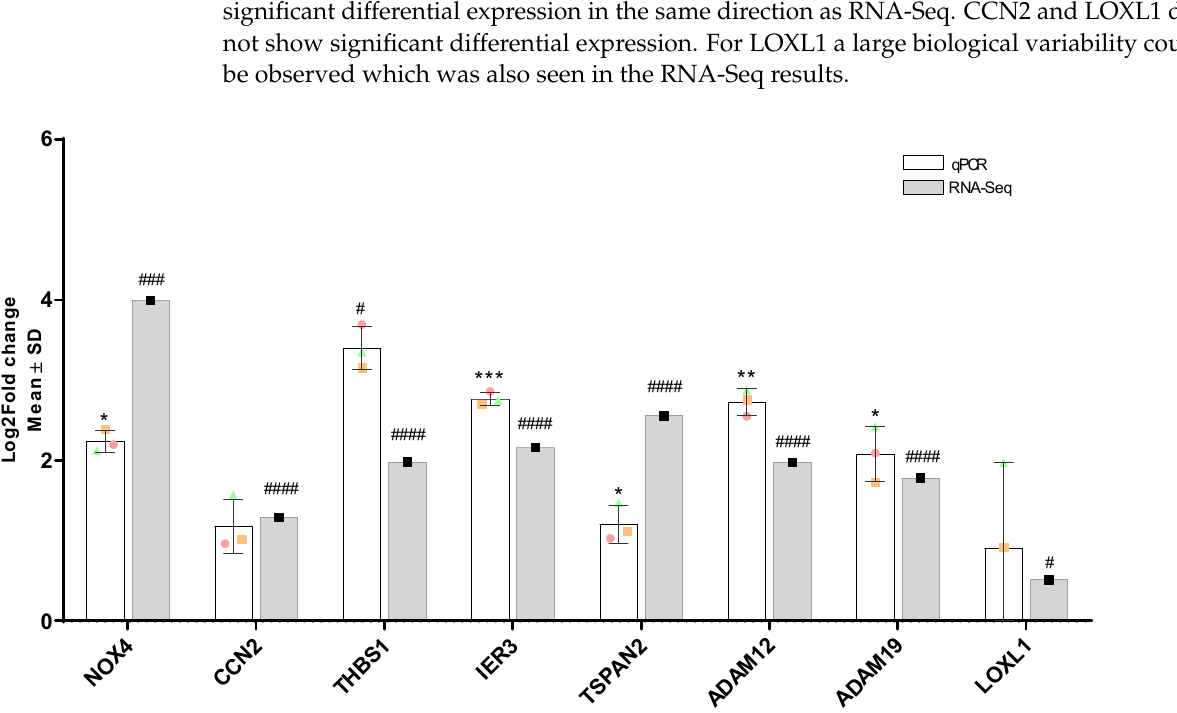
Figure 9. RT-qPCR confirmation and comparison of RNA-Seq results. A total of 3 control and TGF- β 1 stimulated TM donor samples (labelled green, red, orange) that had previously been subjected to RNA-Seq analysis were used to validate gene expression patterns obtained from RNA-Seq analysis using RT-qPCR. Values were normalised to GAPDH and graphed as log 2 fold change. Statistical significance was determined using a two-sample t -test (* p < 0.05, ** p < 0.005, *** p < 0.0005, # p < 0.05, ### p < 0.0005, #### p <